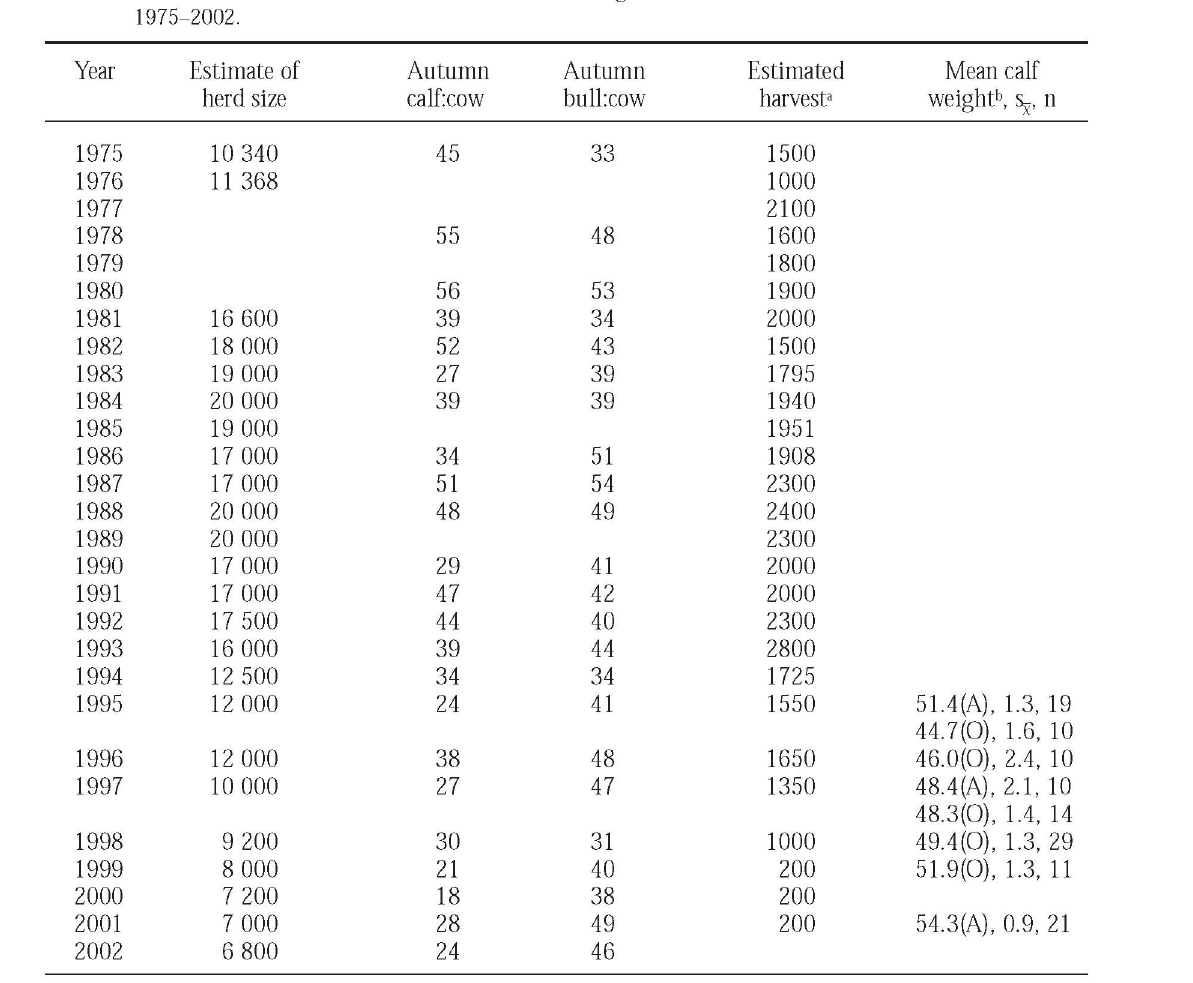
Table 2. Estimates of herd size, fall calfxow ratio, and calf weight in the Northern Alaska Peninsula Caribou Herd, 1975-2002. Estimate of Autumn Autumn Estimated Mean calf calfxow bull:cow harvest